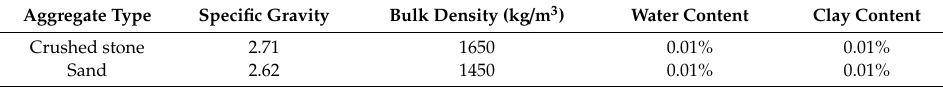
Table 1. Physical properties and composition of crushed stones and sand.